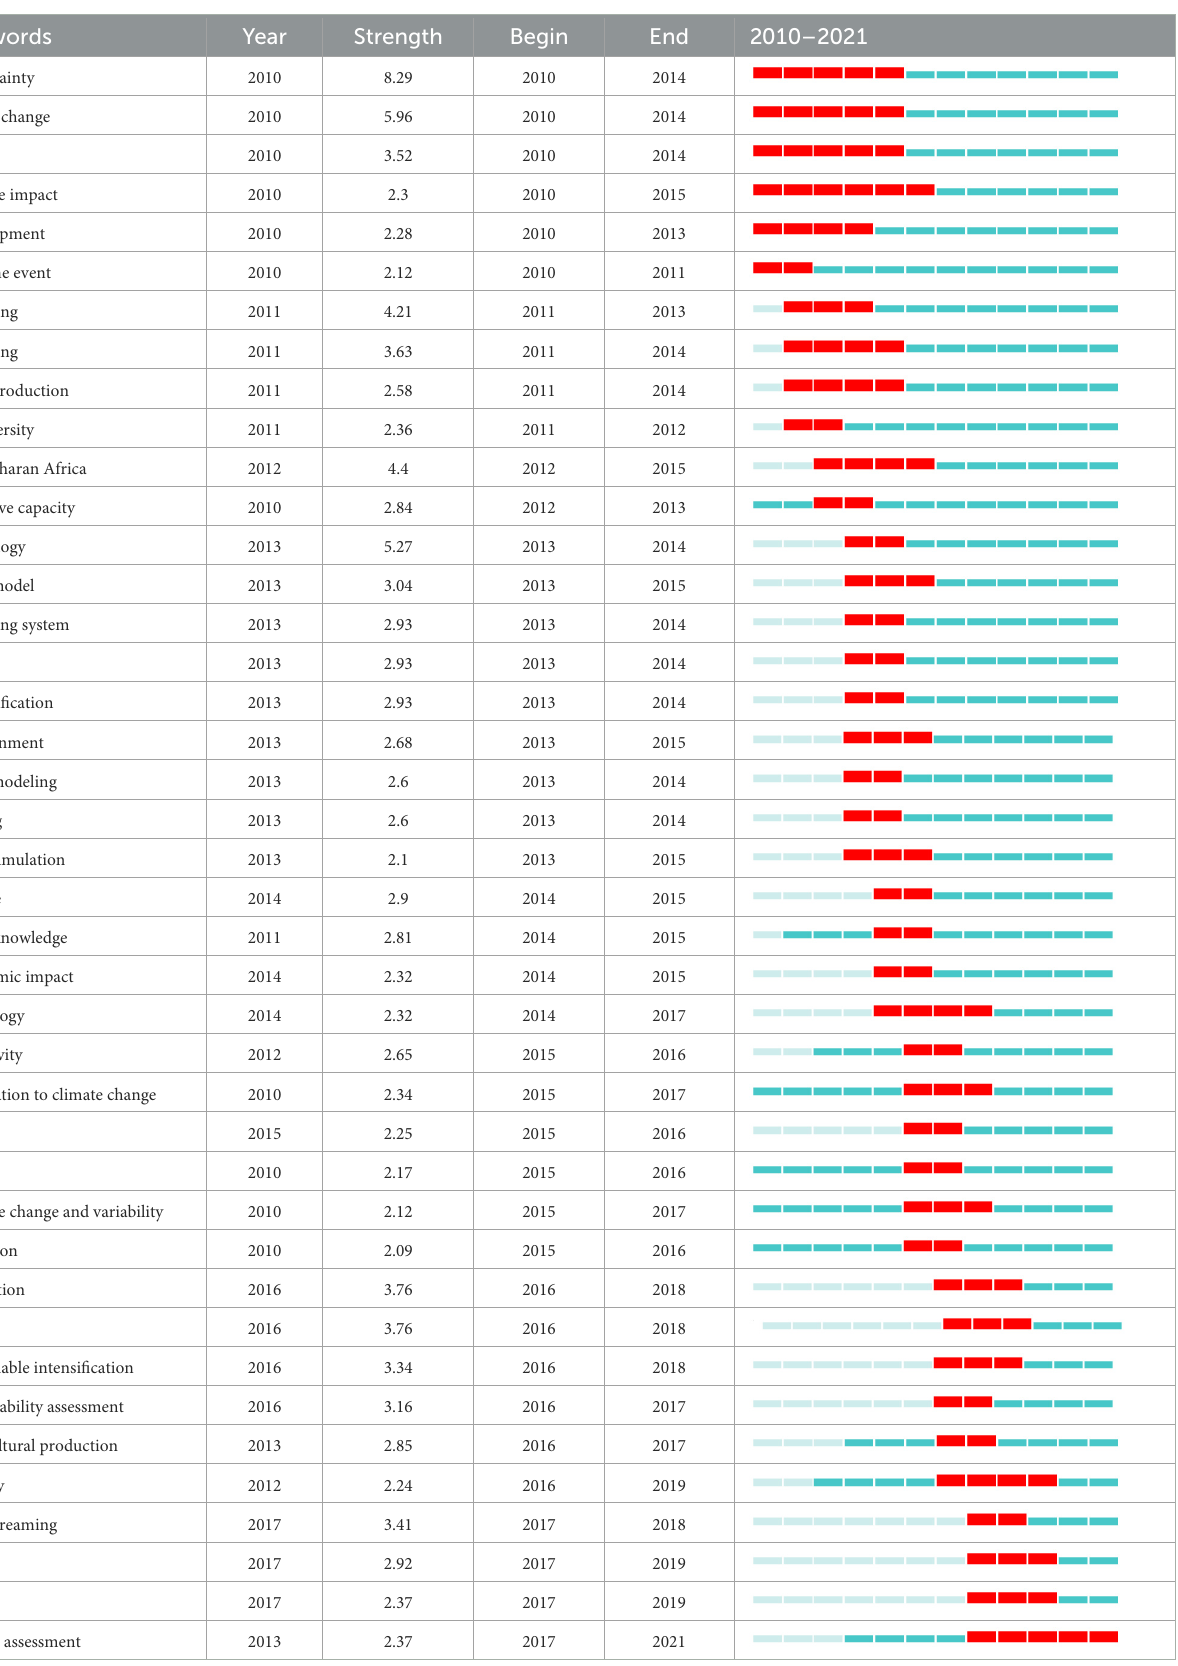
TABLE 4 Top 67 keywords with the strongest citation